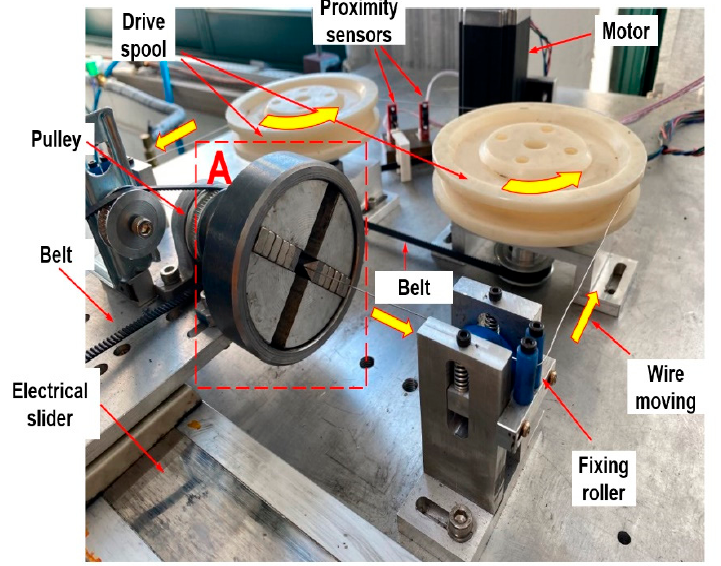
Figure 2. Magnetic abrasive finishing equipment for beta-titanium wire using Nd-Fe-B permanent magnet.